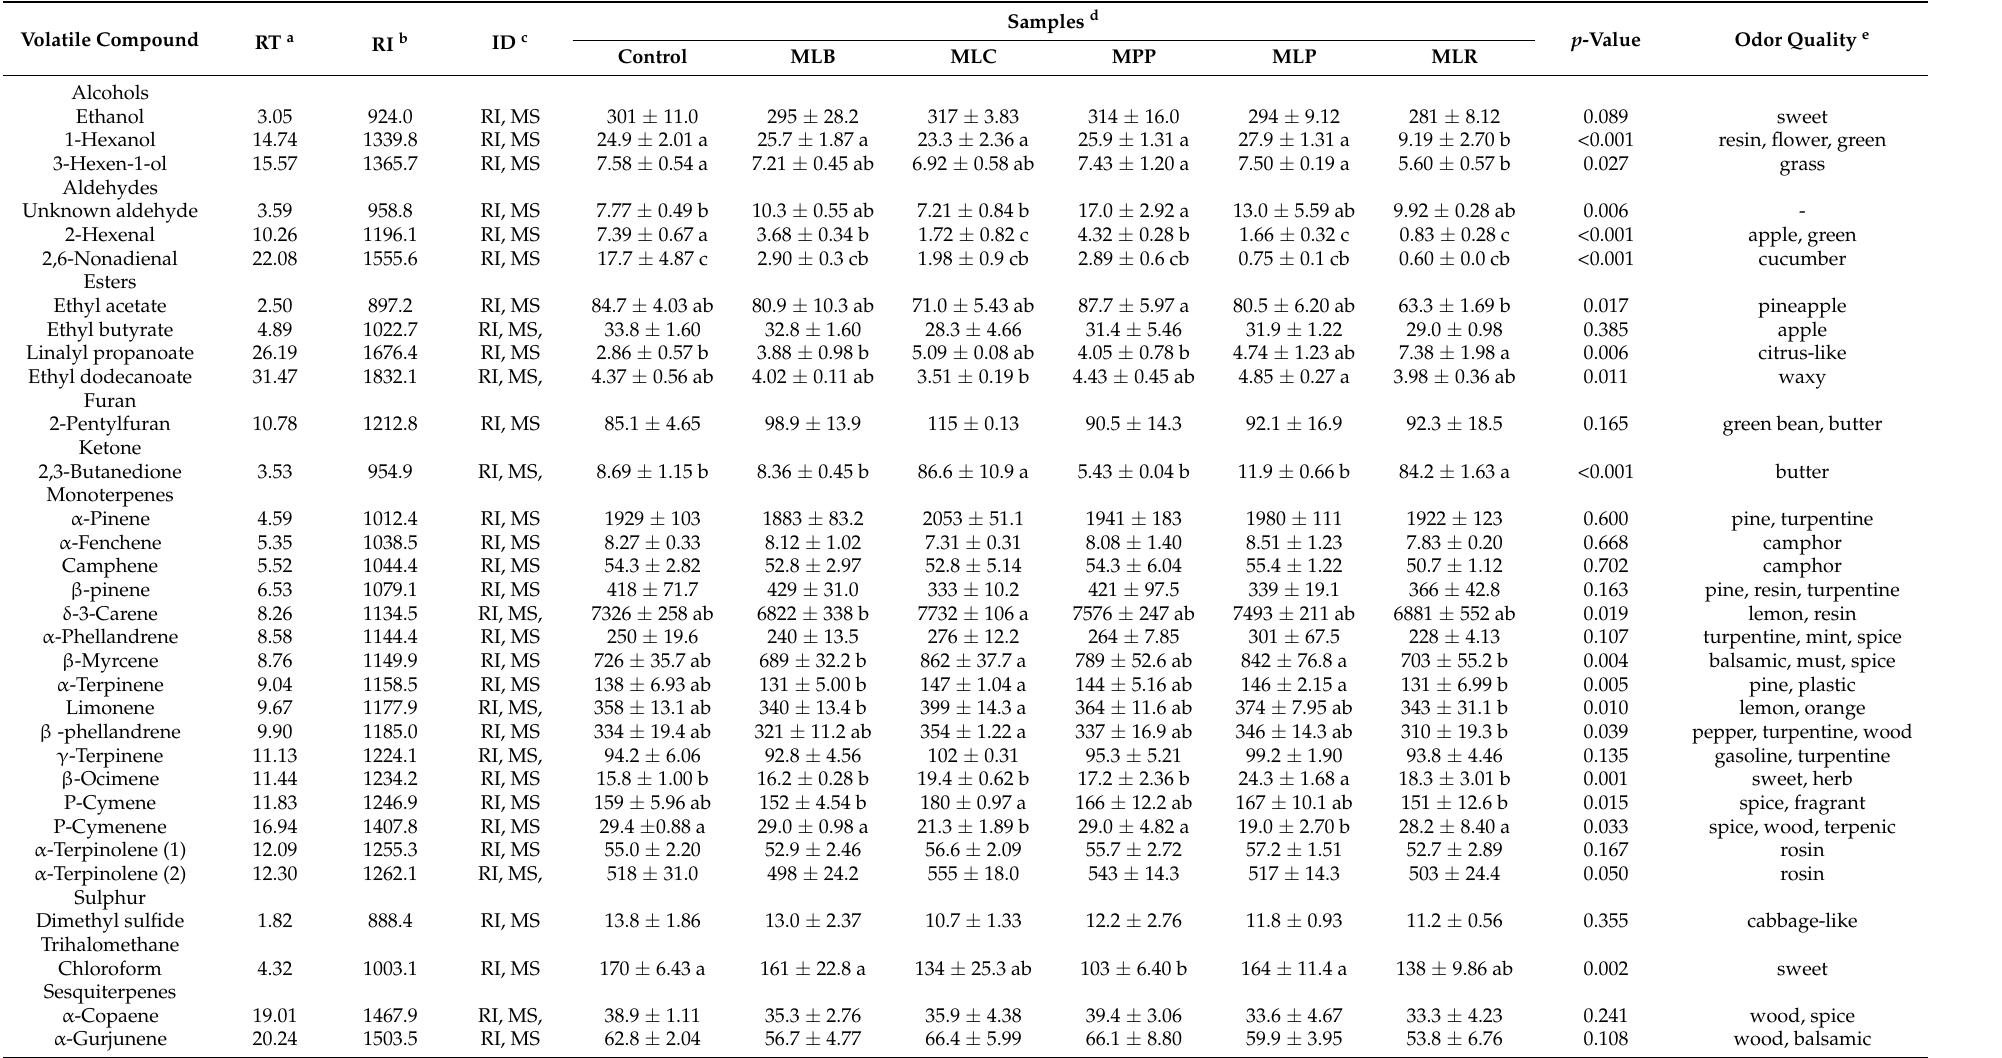
Table 2. Volatile compounds in the control and fermented mango juices expressed as ng/mL of 2-octanol